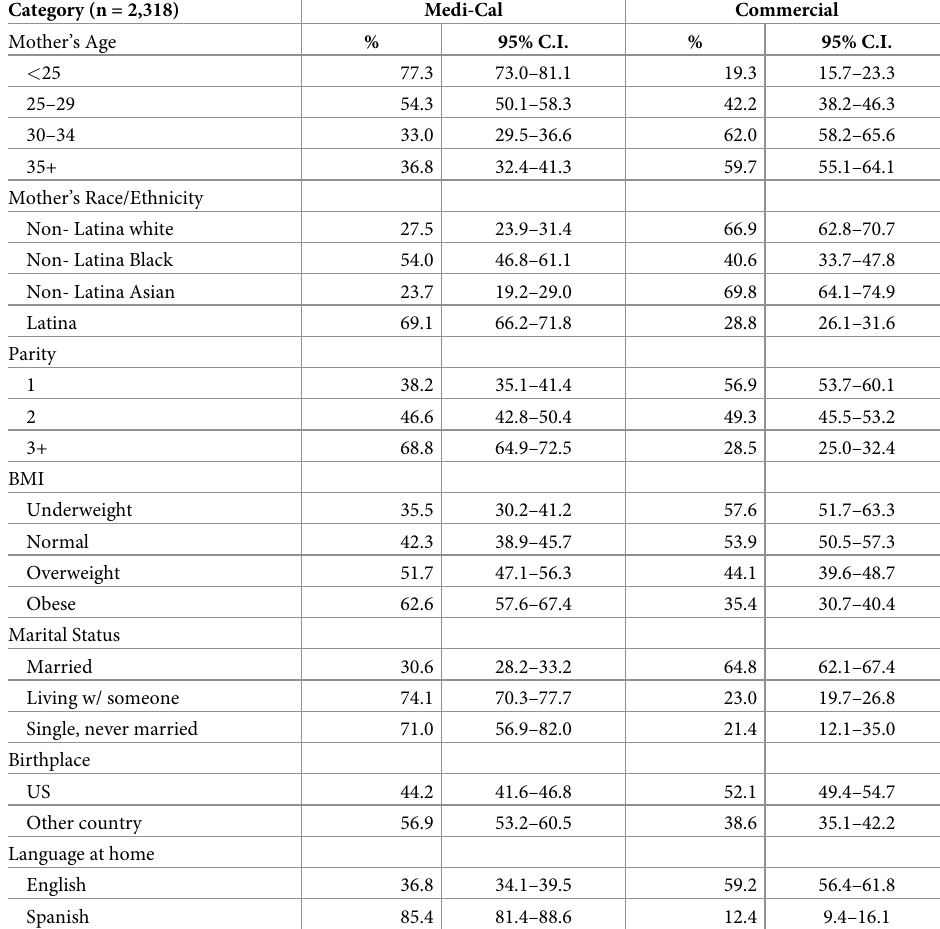
Table 1. Demographic characteristics of childbearing women covered by Medi-Cal and by commercial